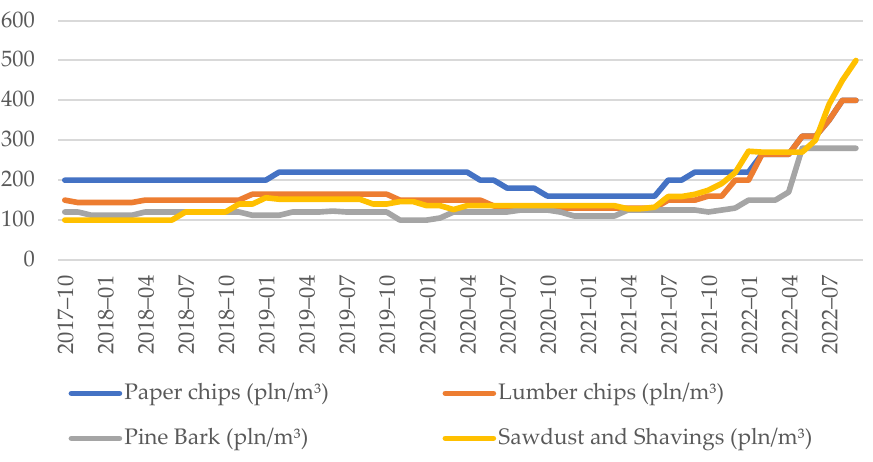
Figure 2. Monthly changes in industrial biomass prices from 2017 to 2022. Source: Own elaboration based on obtained data [33–38].